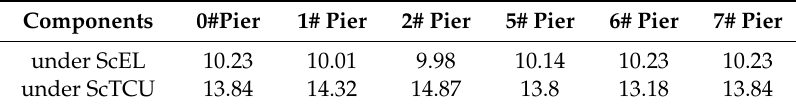
Table 5. Maximum bending moments on bottom sections of piers (unit: N · mm).